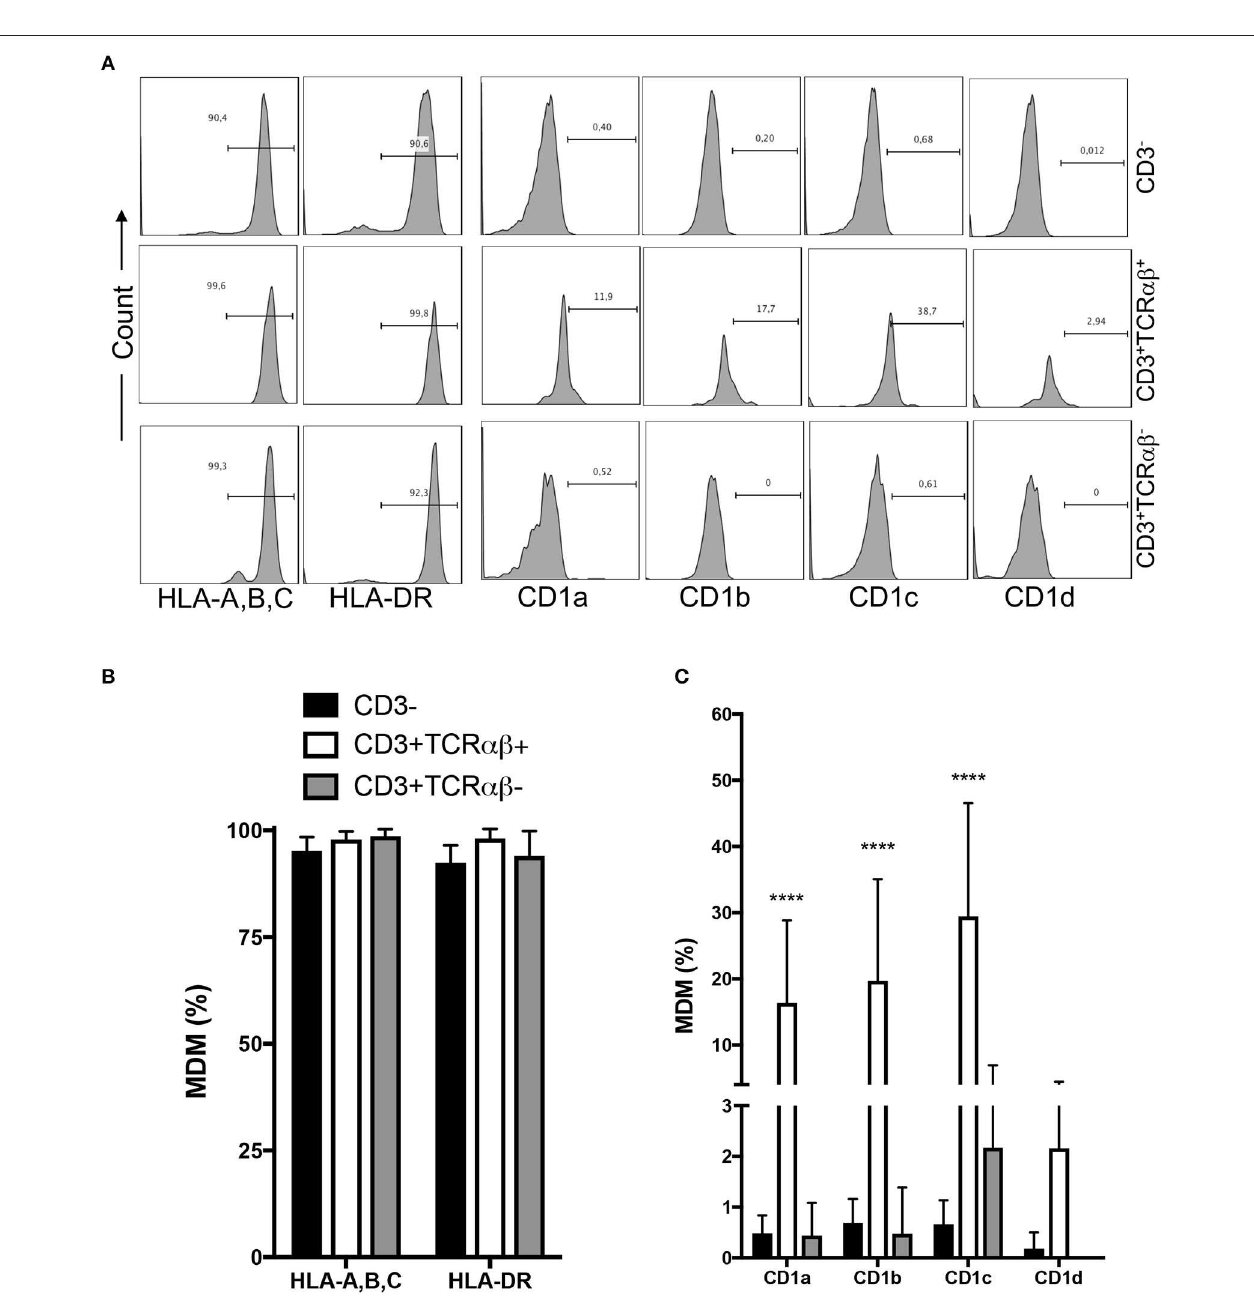
FIGURE 2 | Human CD3 + TCR αβ + and CD3 + TCR αβ − macrophage subpopulations express HLA family molecules, but only CD3 + TCR αβ + co-express a CD1 family member. Human monocyte-derived-macrophage were obtained at the 7th day post-culture and prepared for flow cytometry; the CD3 + MDM subpopulations were delimited. (A) Representative histogram showing the expression of HLA-A,B,C, HLA-DR, CD1a, CD1b, CD1c, and CD1d inside of each CD3 + MDM subpopulation. (B) Frequency of MDM subpopulations expressing the molecules of the HLA family. (C) Frequency of MDM subpopulations expressing the molecules of the CD1 family. The bar graphs show the mean ± SD of n = 8–10 independent donors. A statistical analysis was performed by two-way ANOVA with multiple comparisons, followed by a Tukey test. **** p < 0.0001.